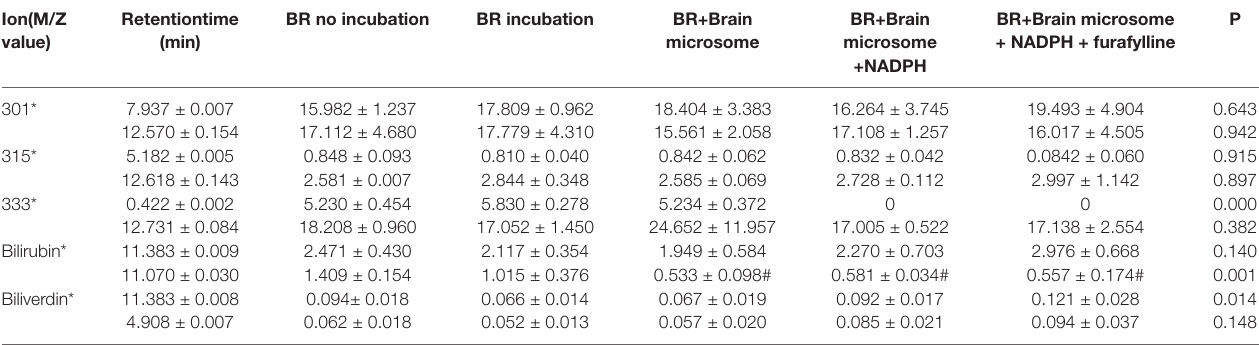
TABLE 4 | Analytical data counts and acquisition time of brain incubation systems. Ion(M/Z Retentiontime value)